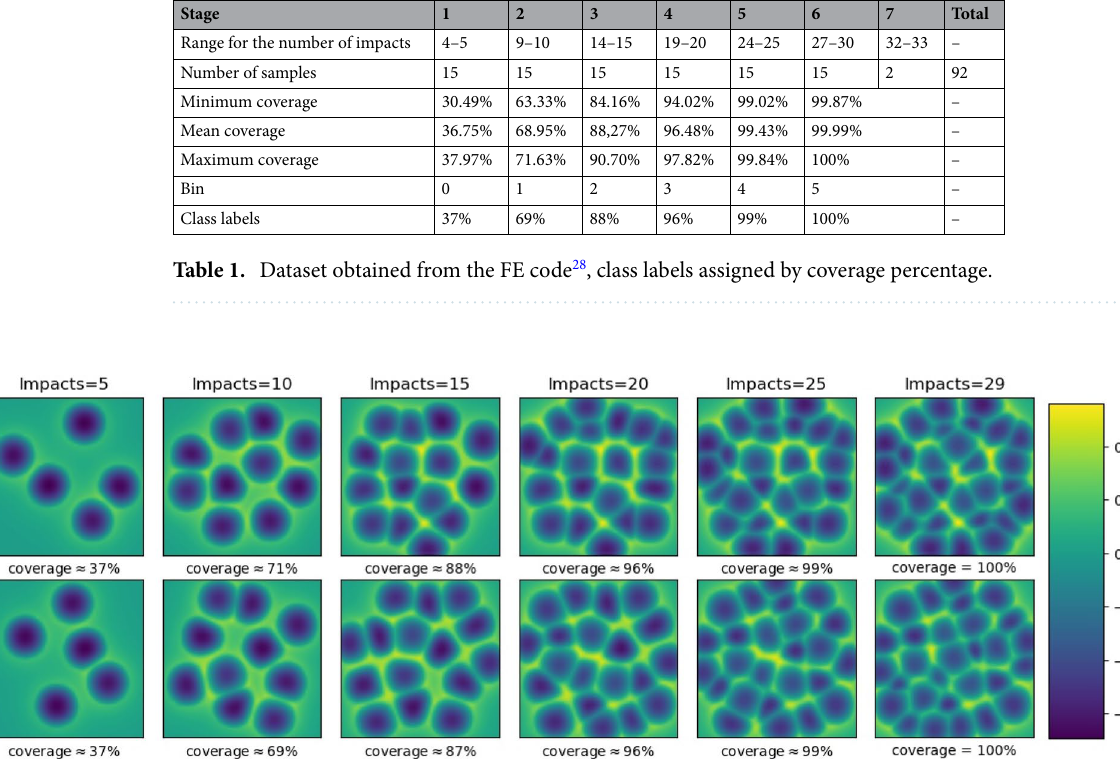
Figure 1. Numerical surface samples, colouring by height of the associated surface, for two sequences with number of impacts and estimated coverage percentages per